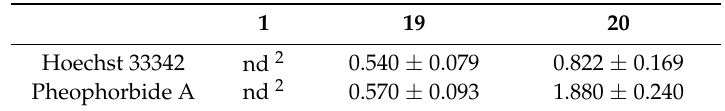
Table 1. Breast cancer resistance protein (BCRP) inhibition by compounds 19 and 20 compared to quercetin 1 .